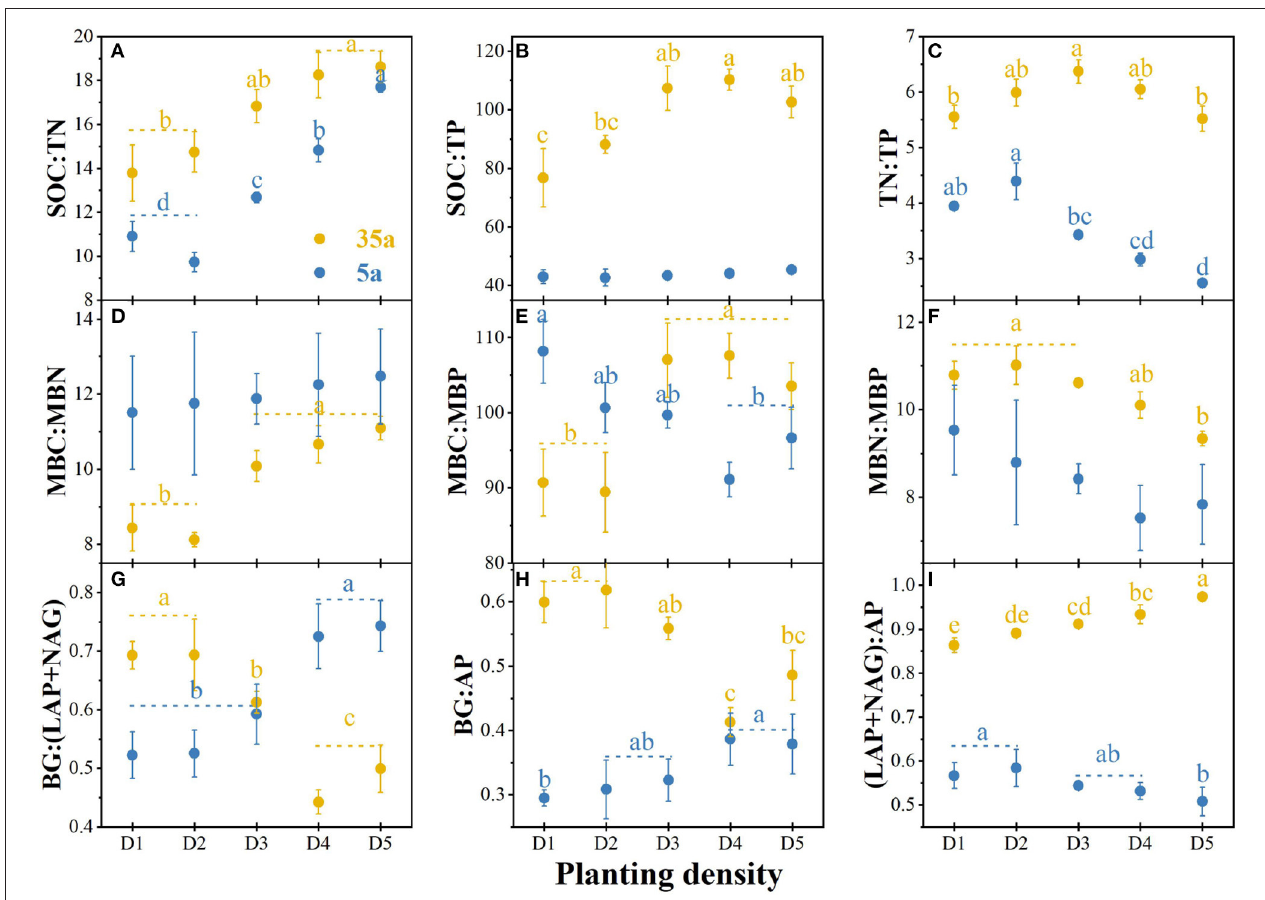
FIGURE 2 | Soil carbon (C)/nitrogen (N)/phosphorus (P) stoichiometry, microbial biomass C/N/P stoichiometry, and enzymatic C/N/P stoichiometry in 5-year-old (5a, blue) and 35-year-old (35a, yellow) plantations. C acquisition is represented by β -glucosidase (BG); N acquisition is measured by the potential activities of leucine aminopeptidase (LAP) and β -1,4-N-acetylglucosaminidase (NAG); P acquisition is measured as acid phosphatase (AP) activity; MBC, microbial biomass carbon; MBN, microbial biomass nitrogen; MBP, microbial biomass phosphorus; SM, soil moisture; SOC, soil organic carbon; TN, total nitrogen; TP, total phosphorus. Different lowercase letters represent significant differences between different planting densities ( p < 0.05). The data are shown as the mean ± standard deviations ( n = 3). D1, 1,667 stems ha − 1 ; D2, 3,333 stems ha − 1 ; D3, 5,000 stems ha − 1 ; D4, 6,667 stems ha − 1 ; D5, 10,000 stems ha − 1